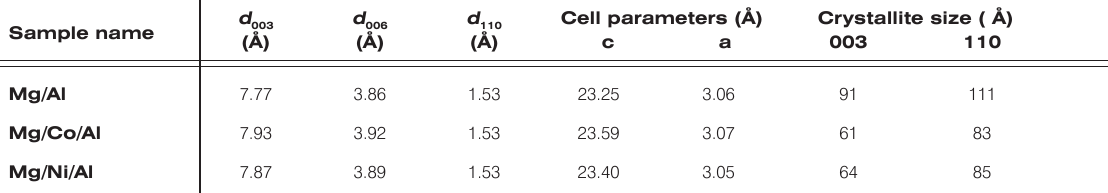
Table 1. Crystallographic data and crystallite size of synthesized layered double hydroxides.